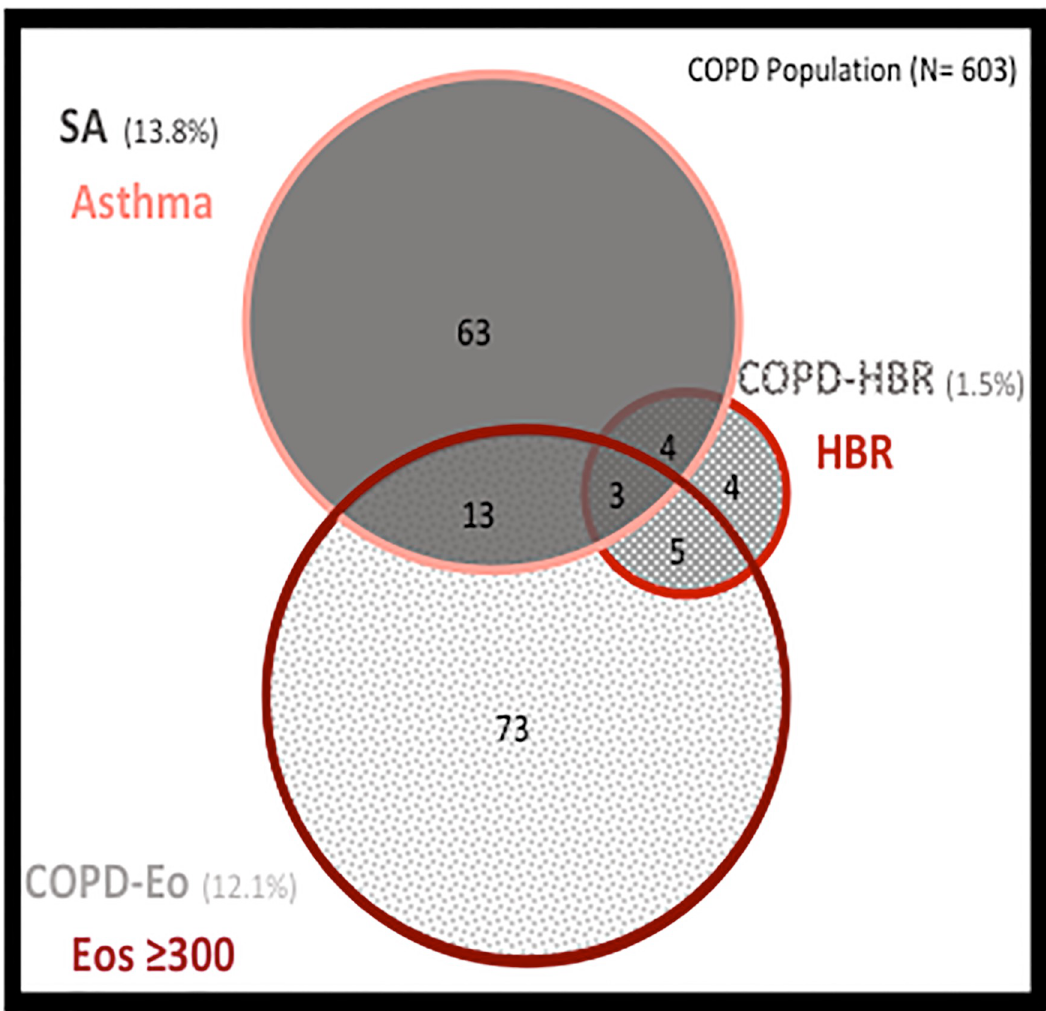
obstructive pulmonary disease; Eos: Eosinophil; ACO: Asthma-COPD overlap; HBR: High bronchodilator response.